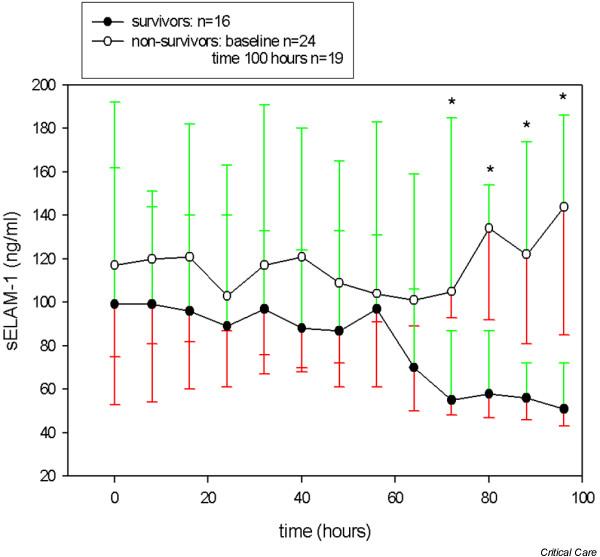
Soluble endothelial-linked adhesion molecule 1 (sELAM-1) for survivors and non-survivors over time. * Significant difference (P < 0.05) for sELAM-1 between survivors and non-survivors.